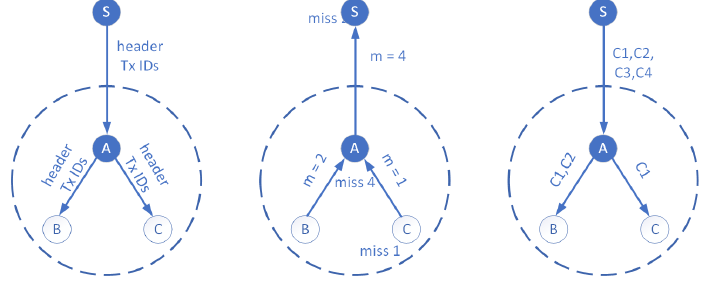
Figure 9. Clustering Technique used by Jin et al.